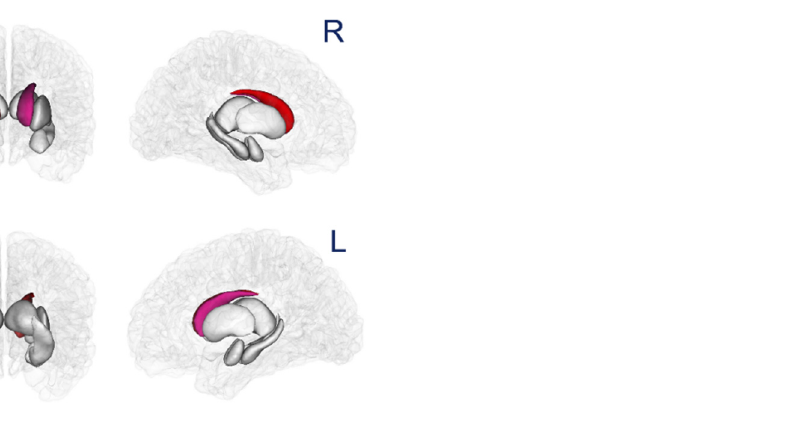
Figure 6. Visualization of the statistical significance of subcortical volumes. Non-significant regions are in white, significant regions (following correction for multiple comparison) are shown in blue ( p < 0.05) to red ( p < 0.001).